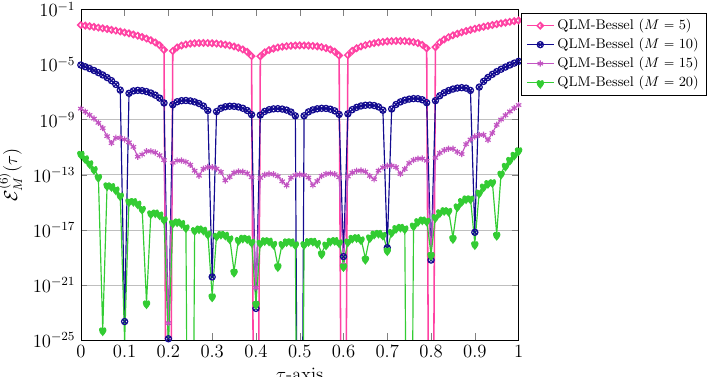
Figure 3. Comparison of residual error functions in QLM-Bessel for various M = 5,10,15,20, and r = 5 in Test case